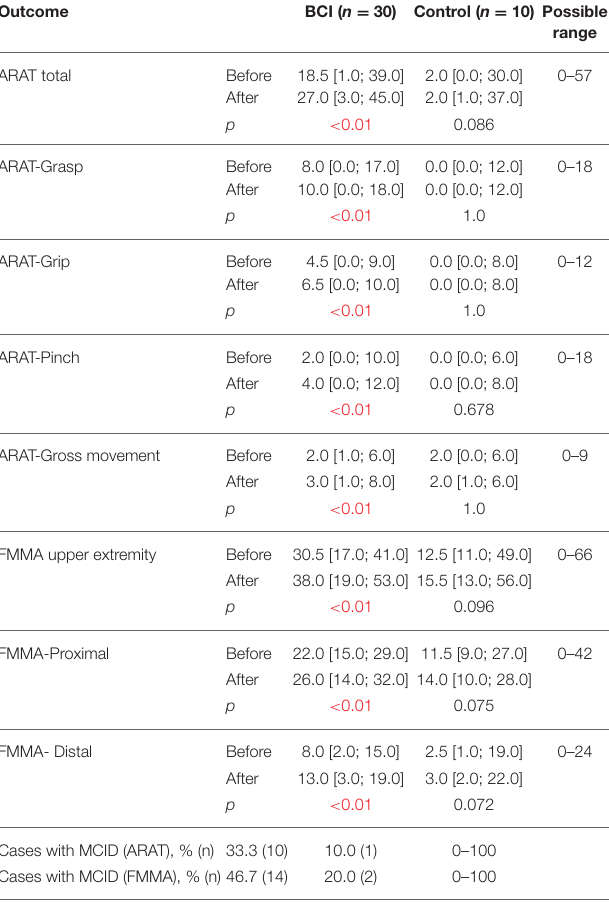
TABLE 4 | Efficacy measures by ARAT and FMMA scores in subacute stroke patients (1–6 months from onset) for each study group. Outcome BCI ( n = 25) Control ( n = 9) Possible